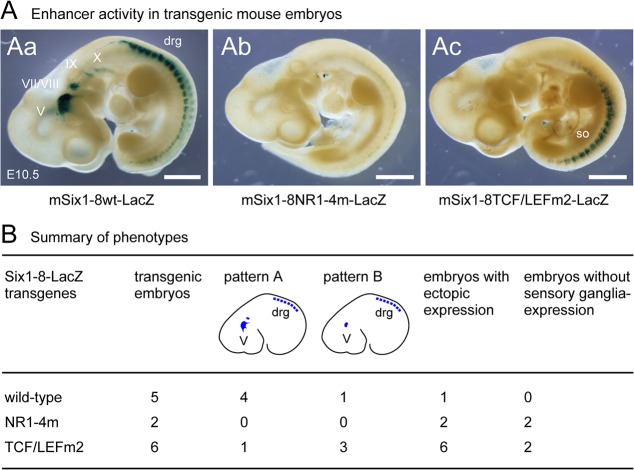
Functional analysis of mSix1-8 in mouse.(A) Mutation analysis of mSix1-8 in mouse. Wild-type (mSix1-8wt-LacZ, Aa) and mutated [(mSix1-8NR1-4m-LacZ, Ab) and (mSix1-8TCF/LEFm2-LacZ, Ac)] transgenes were used for transgenesis and ß-Gal localization was examined at E10.5. Embryos injected with the wild-type transgene showed ß-Gal activity specifically in the trigeminal ganglion, the VII/VIII ganglion complex and epibranchial placode/ganglia (Aa)[17]. However, ß-Gal activity was almost completely lost in an embryo carrying NR1-4m mutation, with the exception of a small number of ectopic ß-Gal-positive cells in the cervical area (Ab). In an embryo carrying TCF/LEFm2 mutation, ß-Gal activity was lost in the sensory organs and ganglia, with the exception of ectopic activity in the somites (Ac). drg: dorsal root ganglia, so: somites, V: trigeminal ganglion, VII/VIII: VII/VIII ganglion complex, IX: petrosal ganglion, X: nodose ganglion. Scale bars: 1 mm. (B) Summary of the phenotypes of transgenic mouse embryos. transgenic embryos: the total number of transgenic embryos obtained using each transgene, pattern A: number of embryos with ß-Gal staining pattern in which the signal in the trigeminal ganglion stands out as the major ß-Gal-positive domain (Fig 3Aa represents a typical pattern A staining), pattern B: number of embryos with ß-Gal staining in which signals in the cranial ganglia was reduced while those in the DRG were relatively unaffected, embryos with ectopic expression: number of embryos with an ectopic LacZ staining, embryos without sensory ganglia-expression: number of embryos without a LacZ staining in the sensory ganglia. Parts of the results obtained using the wild-type transgene were reported previously [17].